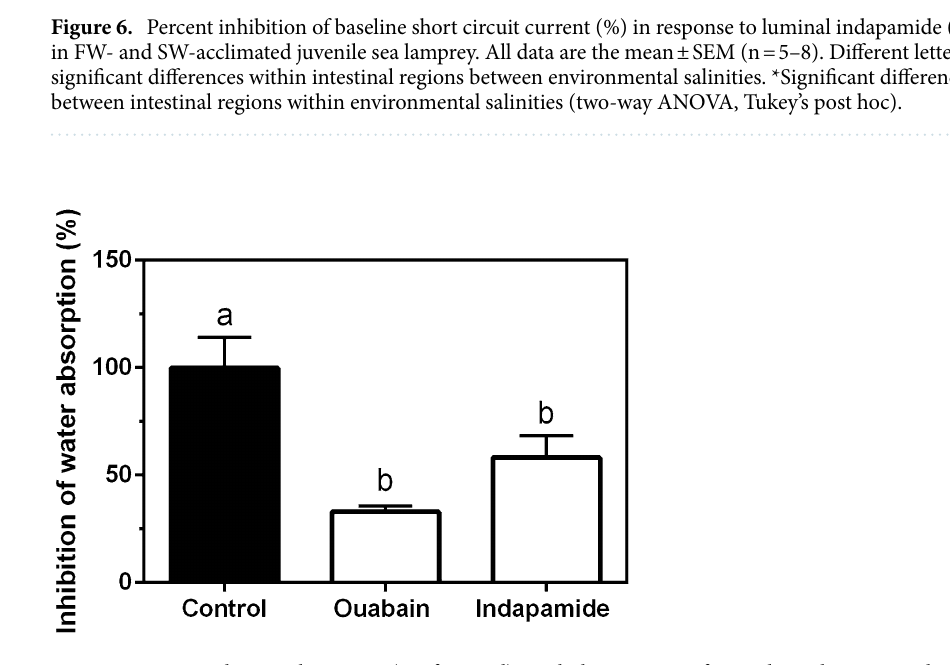
Figure 7. Intestinal water absorption (% of control) in whole intestines of juvenile sea lamprey acclimated to SW. Ouabain (500 µM) was added to the serosal side, and indapamide (400 µM) was added to the luminal side. All data are presented as mean ± SEM (n = 3–4). Different letters indicate significant differences among groups (one-way ANOVA, Tukey’s post